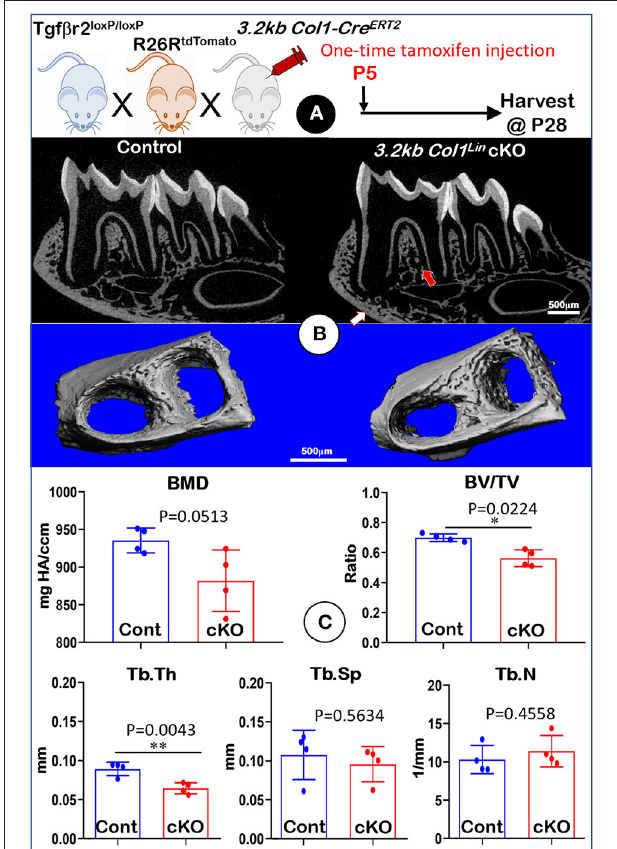
FIGURE 4 | Micro-computed tomography ( µ CT) analyses of mandibles from 3.2kb Col1 Lin Tgf β r2 conditional knockout (cKO) mice. (A) A schematic illustration of the generation of the 3.2kb Col1-Cre ERT 2 induced Tgf β r2 mice in the R26R tdTomato tracing background. A one-time tamoxifen injection was administered at P5, and harvested at P28. (B) The cKO mice showed a mild decrease of bone mass at both trabecular (red arrow) and cortical (white arrow) regions. (C) Quantitative data based on the trabecular bone showed a reduction in bone mineral density (BMD) with no statistical significance ( upper left ), although there was a significant reduction in bone volume fraction (BV/TV) ( upper right ) and trabecular thickness (Tb. Th) ( lower left ). Of note, there was no apparent change in trabecular separation (Tb.Sp) ( lower middle ) and trabecular number (Tb.N) ( lower right ). n = 4, * P < 0.05 ; ** P < 0.01 .